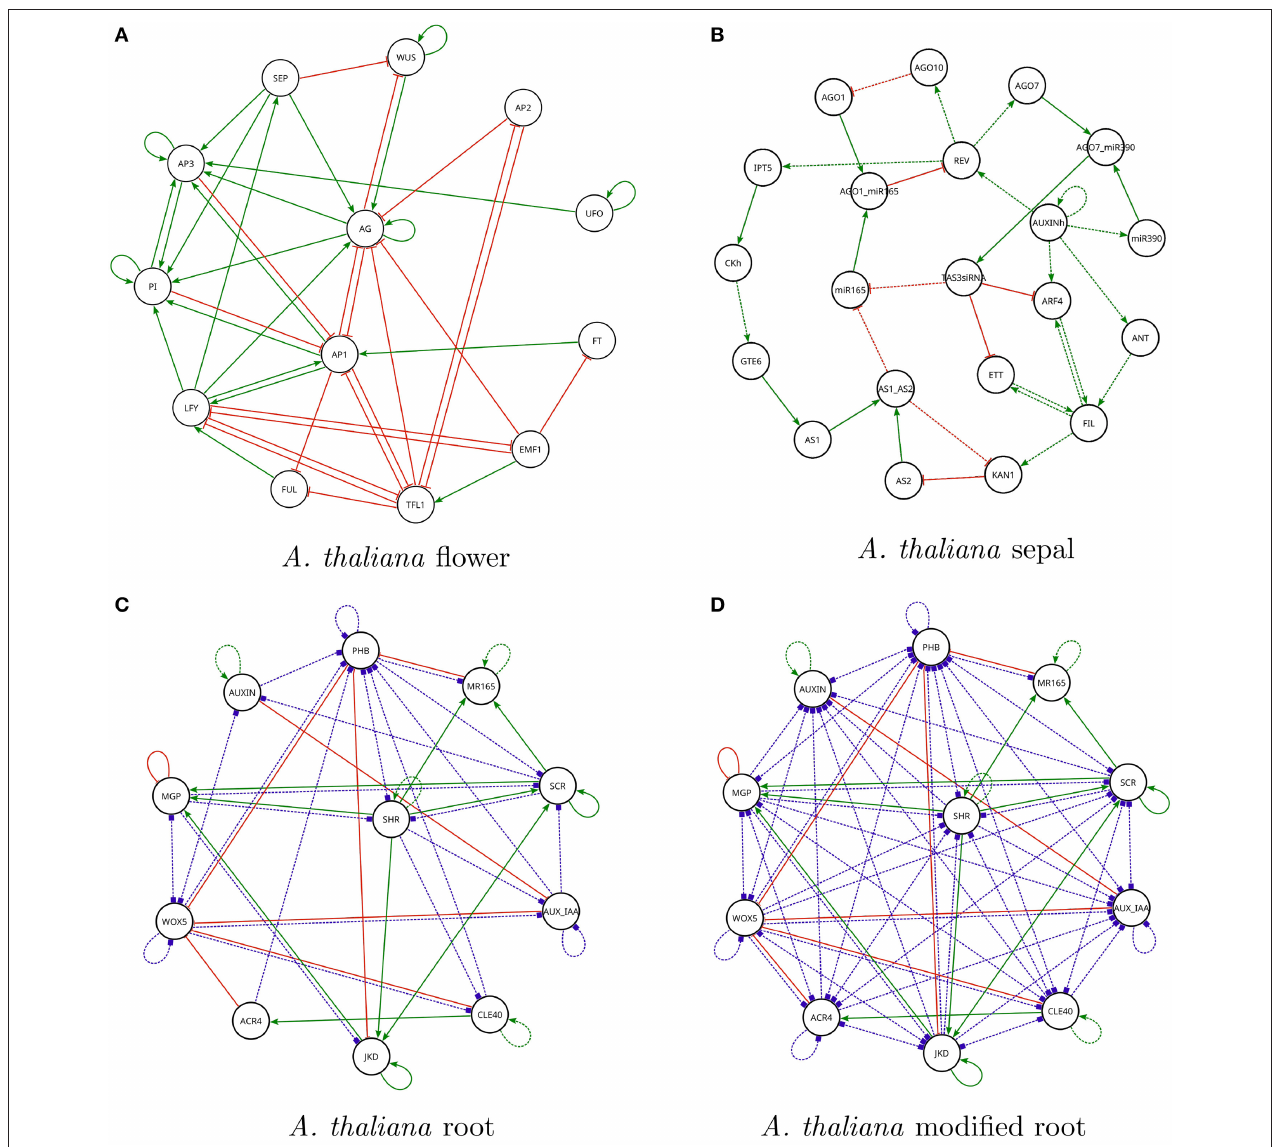
FIGURE 3 | Regulation graphs for A. thaliana models used in the section Case Studies. (A) Flower development model of Alvarez-Buylla et al. (2010). Nodes LUG and CLF have been omitted from the diagram because they are constant inputs to the model. (B) Sepal primordium polarity model of La Rota et al. (2011). For all figures: positive regulations are shown as green lines with arrow tips, negative regulations are shown as red lines with orthogonal line tips, dashed lines represent hypothetical interactions (it is unknown whether they are present or not). Blue dashed lines with square tips represent hypothetical interactions of unknown sign. (C) Root cell stem niche model of Azpeitia et al. (2013). (D) Modified root cell stem niche model of Azpeitia et al. (2013) is shown with several new